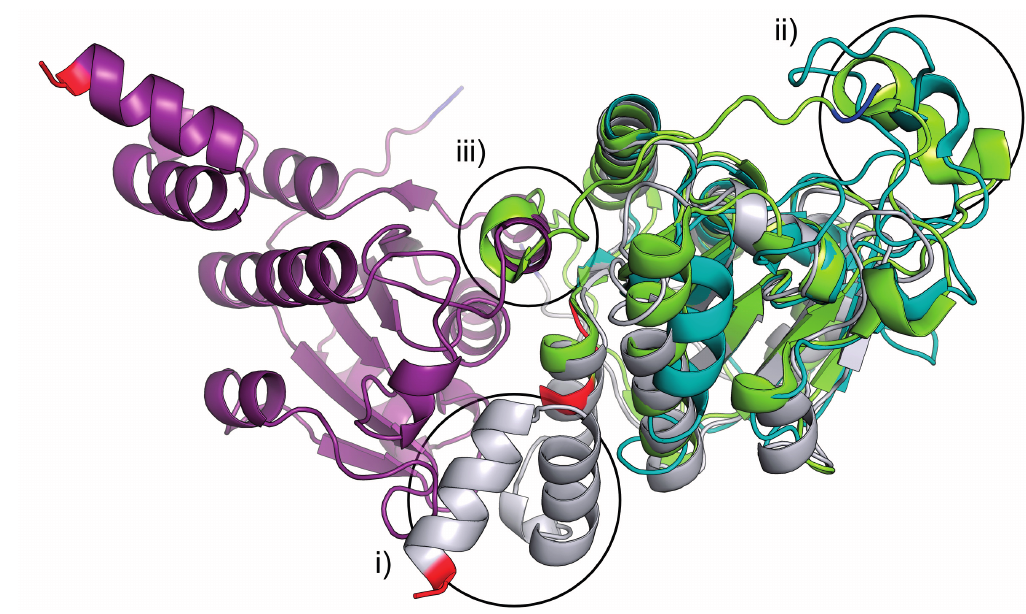
Figure 2. Ribbon representation of the least-squares superposition of chain A and B of Pa YcaC shown in purple and silver, the isochorismatase PhzD from P. aeruginosa (1NF9) [11] in lime and Mtb PncA (3PL1-a nicotinamidase) [12] in teal. N-terminal residues are colored blue, and C-terminal residues are colored red. (i) PhzD and PncA are both missing the YcaC C-terminal helices that form the active site with the neighboring chain; (ii) the large loop would prevent tetramerization if present in YcaC; (iii) as would the additional N-terminal helix present in PhzD. N- and C-termini are highlighted in blue and red,